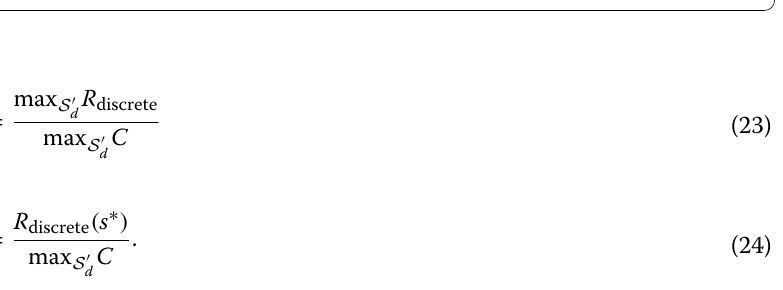
Fig. 15 Outage avoidance. Demonstration of how liquid metal antennas avoid outages. See text for